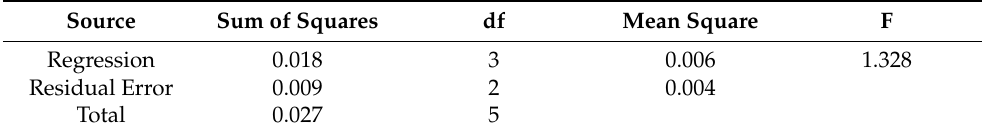
Table 6. Analysis of variance